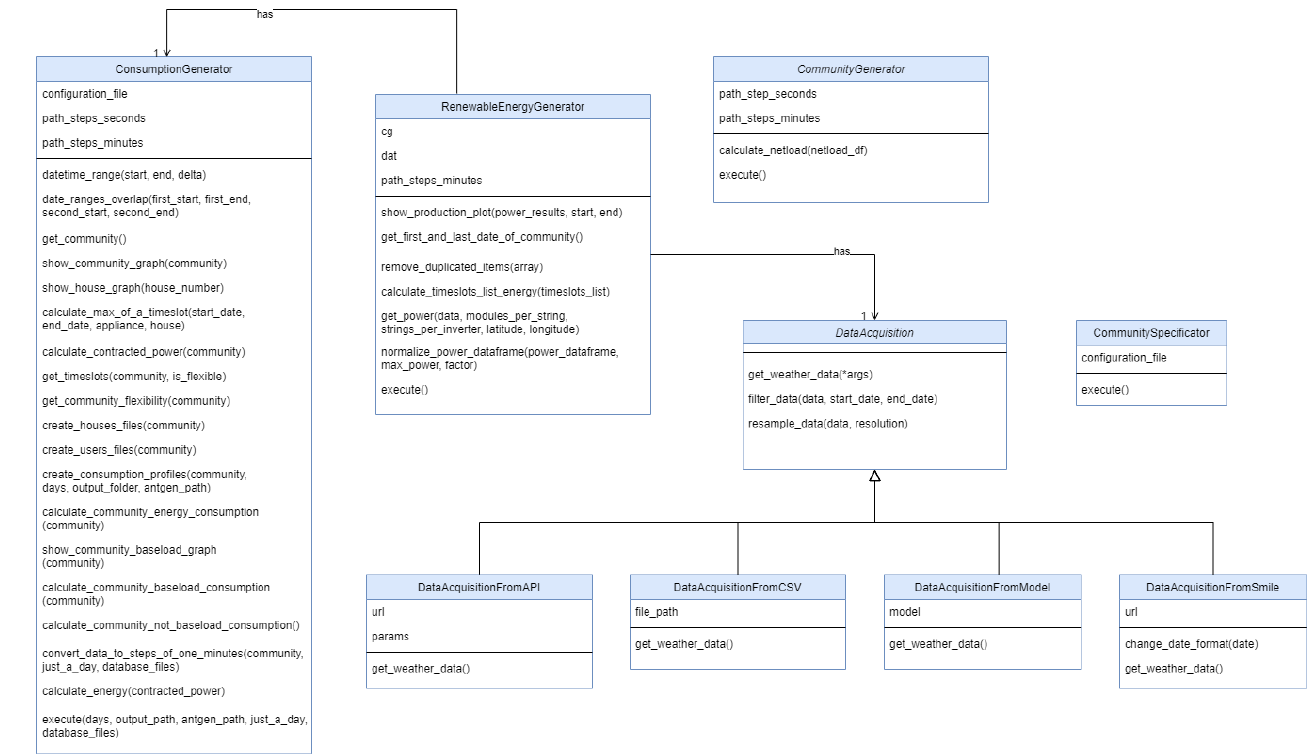
Figure 2. UML diagram of